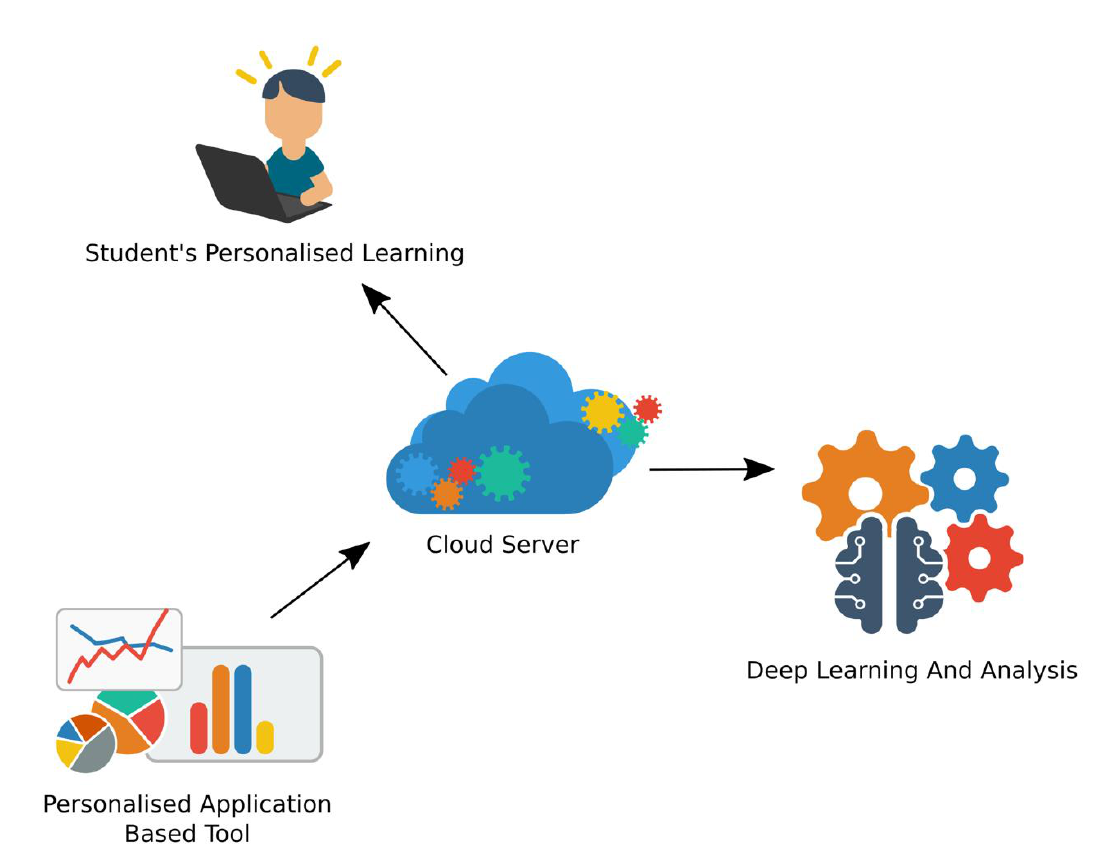
Figure 12. Proposed AI-based tool for personalised learning.